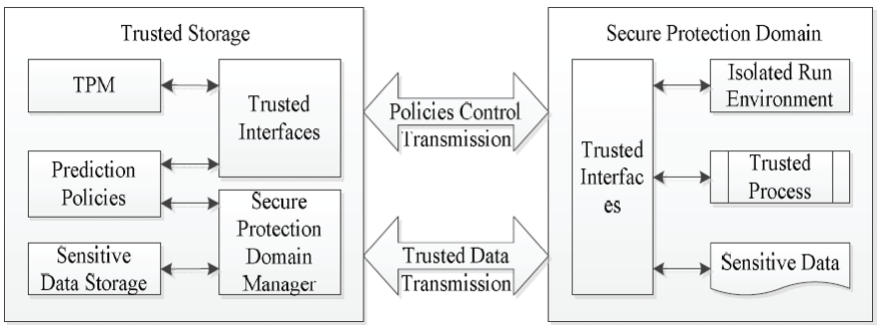
Figure 6. Trusted data-protection mechanism